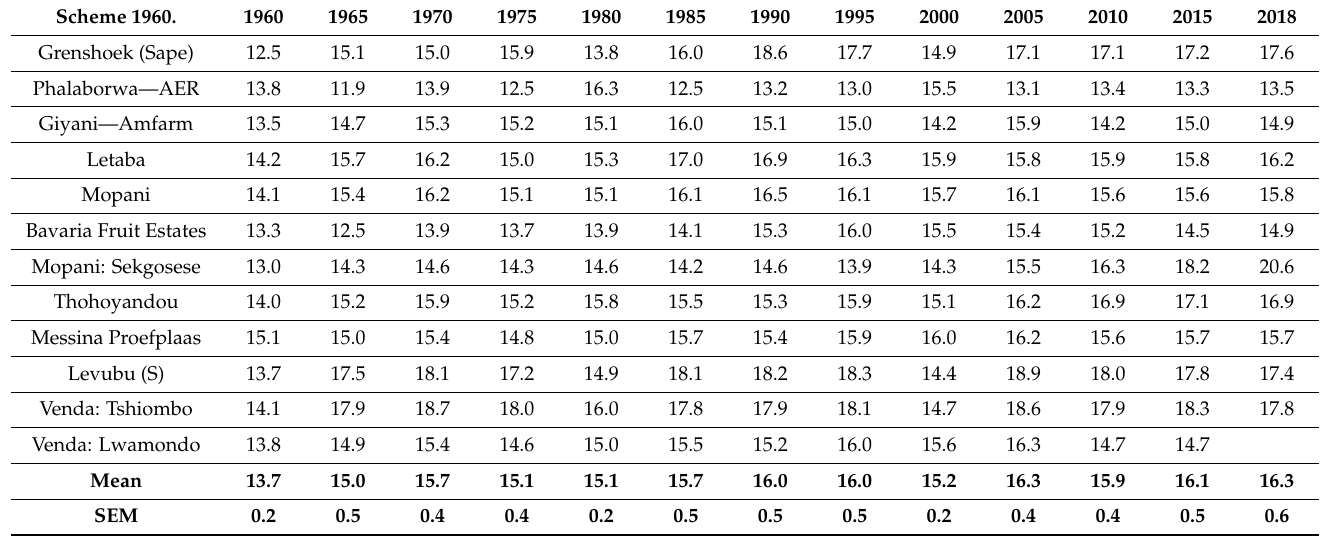
Table 3. The average annual minimum temperature in the Mopani and Vhembe districts. Scheme 1960.